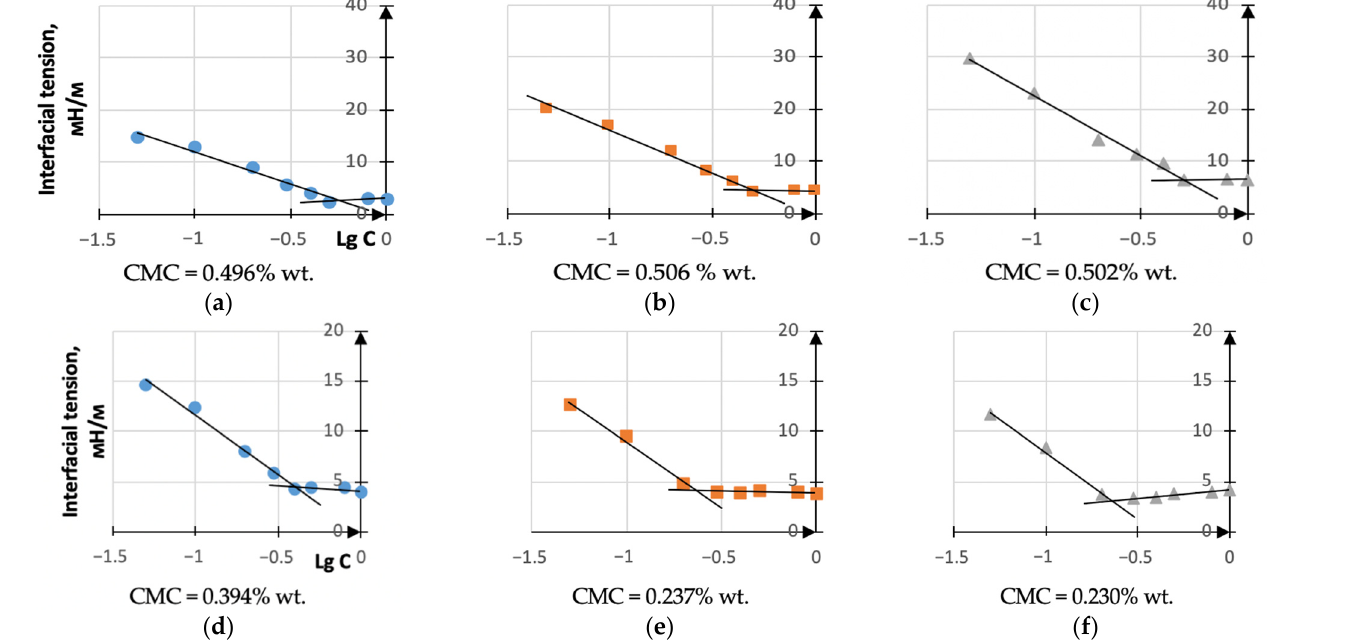
Figure 1. Dependence of the interfacial tension index on the logarithm of concentrations for hydro- chloric acid 5 ( a ), 10 ( b ), 15 ( c ) % wt. with the addition of IC-1 and for sulfamic acid 5 ( d ), 10 ( e ), 15 ( f ) % wt. with the addition of IC-2.